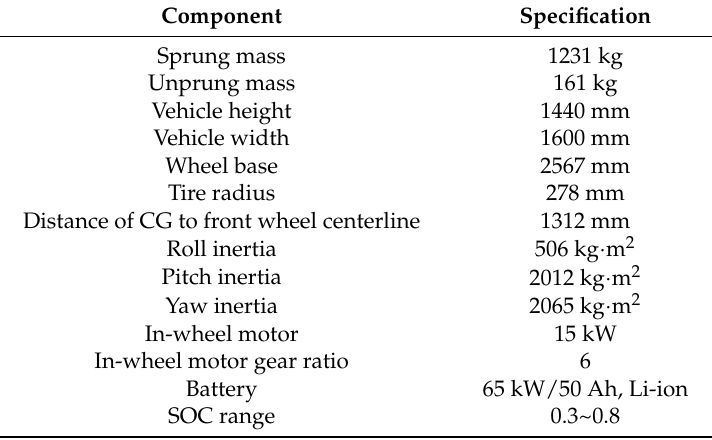
Table A1. Parameters of the target in-wheel electric